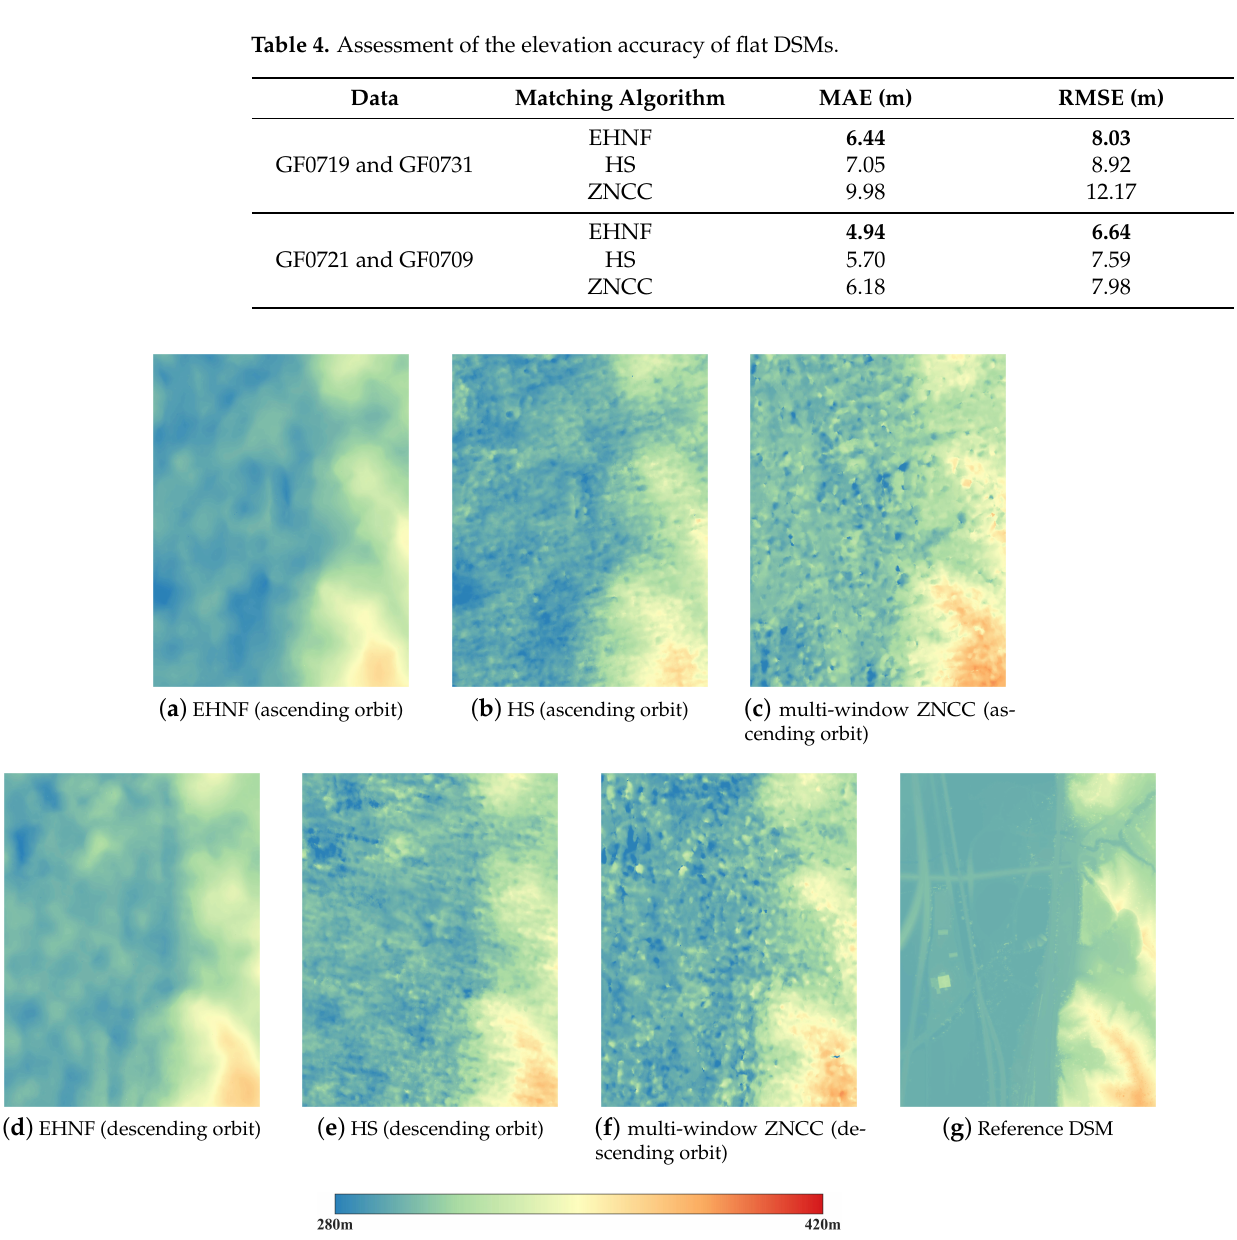
Figure 9. The flat DSM generated by the ( a ) EHNF algorithm; ( b ) HS flow algorithm; ( c ) multi- window ZNCC algorithm of ascending orbit stereo images, and ( d ) EHNF algorithm; ( e ) HS flow algorithm; ( f ) multi-window ZNCC algorithm of descending orbit stereo images. ( g ) The reference DSM generated by LiDAR